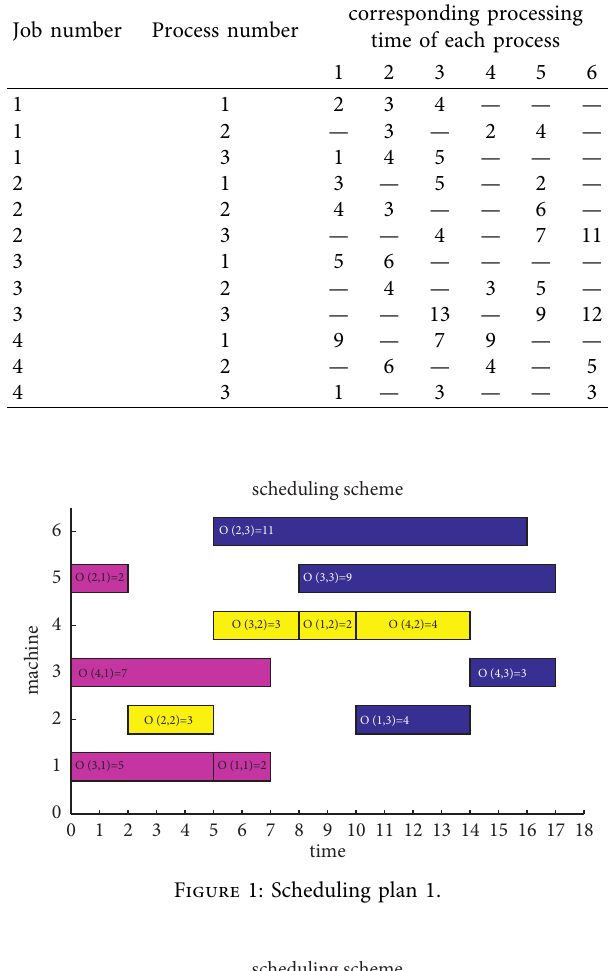
Table 1: Six task scheduling examples. Job number Process number